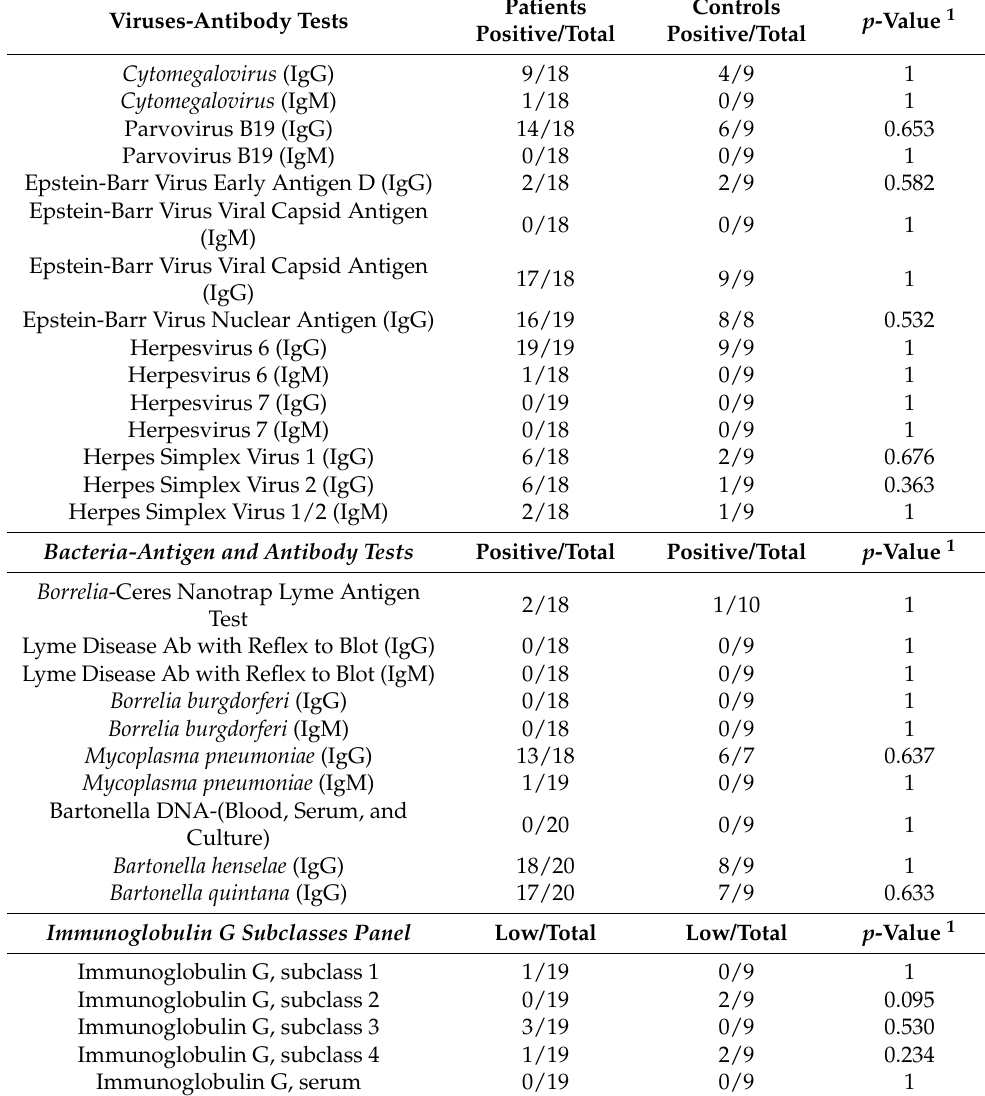
Table 3. Tests on antibodies and